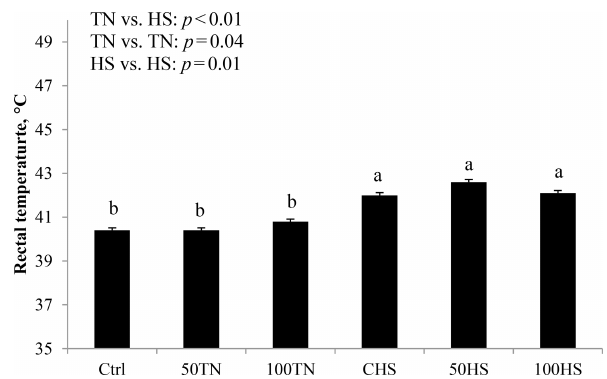
Figure 2. Effects of feeding different levels of organic zinc under TN and HS conditions on rectal temperature in broiler chickens. Results are expressed as the least squares mean (LSM) ± standard error of the mean